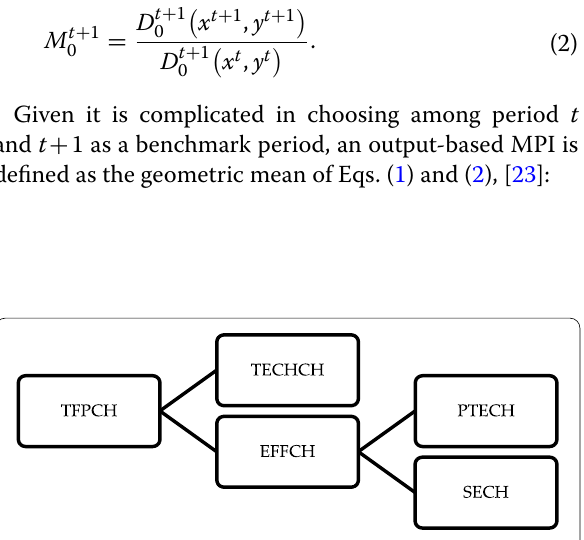
Fig. 1 Interactive relationship among the MPI efficiency